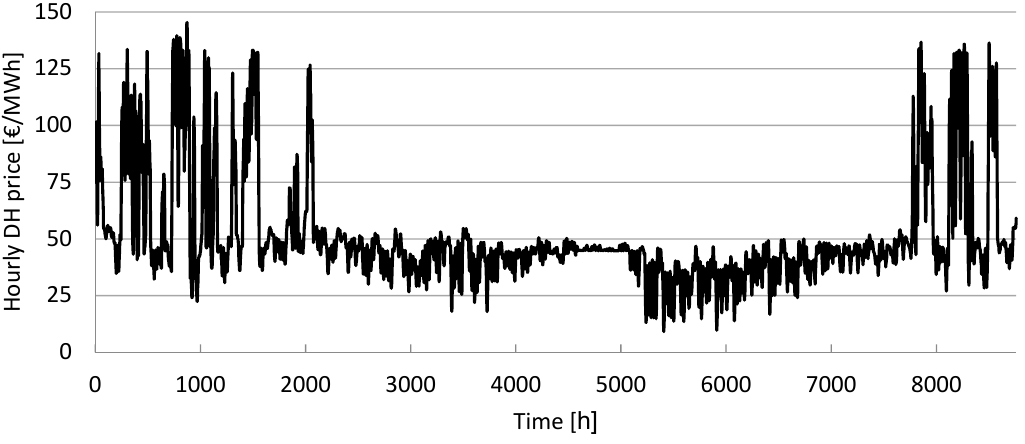
Figure 2. The dynamic DH price used in the study.